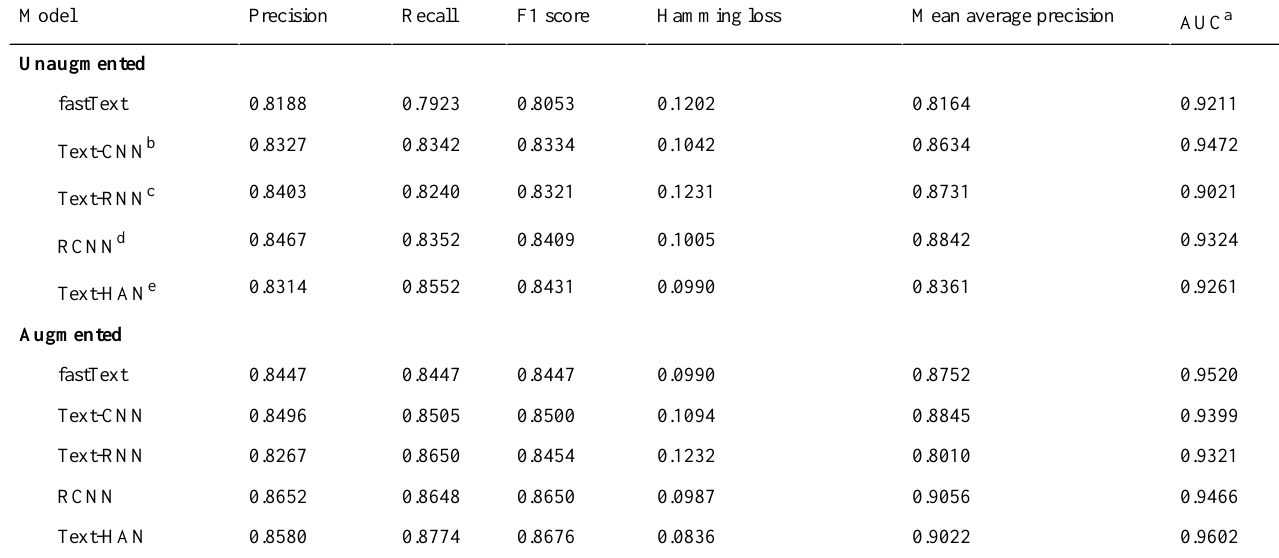
Table 2. Character encoding–based multilabel classification results.